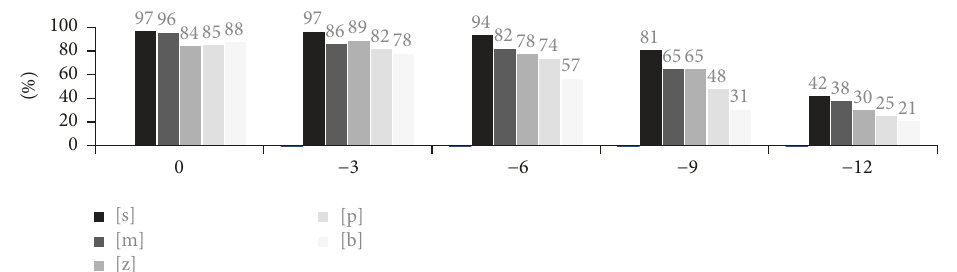
Figure 9: Correct recognition of consonants in first stressed syllable against pink noise.